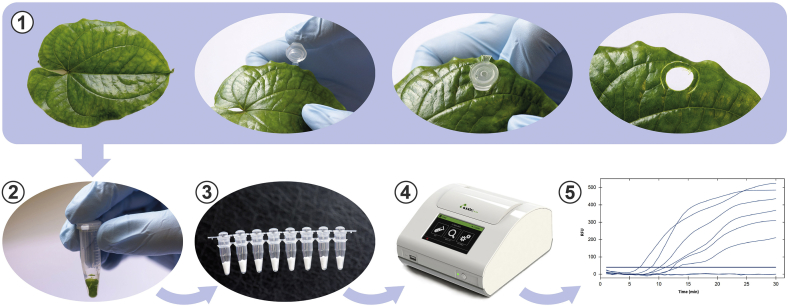
Direct RT-RPA detection method workflow showing sample processing and assay setup steps. 1 - punch leaf with lid of 1.5 mL tubes; 2 - immerse leaf disk in alkaline-PEG buffer and incubate at room temperature for <5 min; 3 - resuspend lyophilised pellet; 4 - read fluorescence; 5 - analyse results: an increase in fluorescence above threshold indicates a positive reaction.